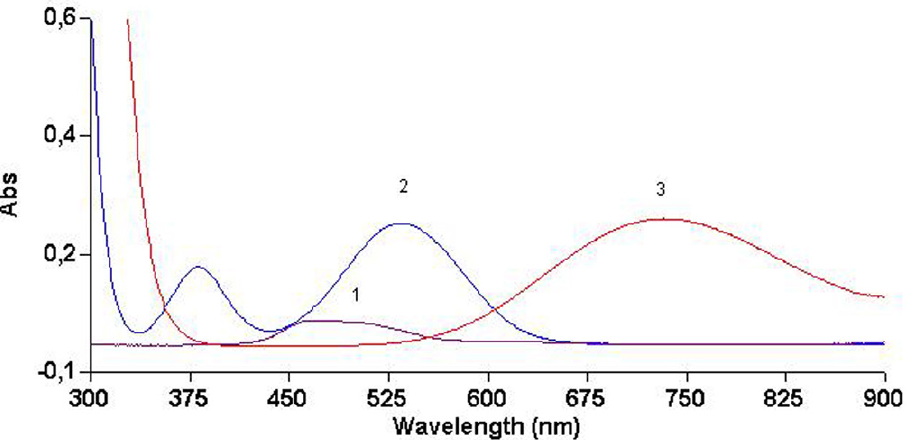
Figure 1. Absorption spectra of the complexes: (1) Co (II)-EDTA, (2) Co(III)-EDTA and (3) Cu(II)-EDTA in a sodium acetate-acetic acid buffer, b = 1 cm. C = 2.20×10 -3 mol L -1 ; C = 2.26×10 -3 mol L -1 ; C = 5.00×10 -3 mol L -1 Co(III)-EDTA Cu(II)-EDTA Co(II)-EDTA